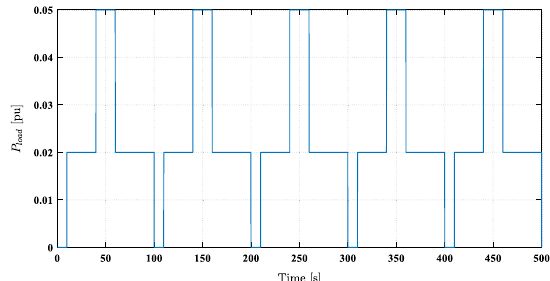
Fig. 14 The load power fluctuation of Case 3